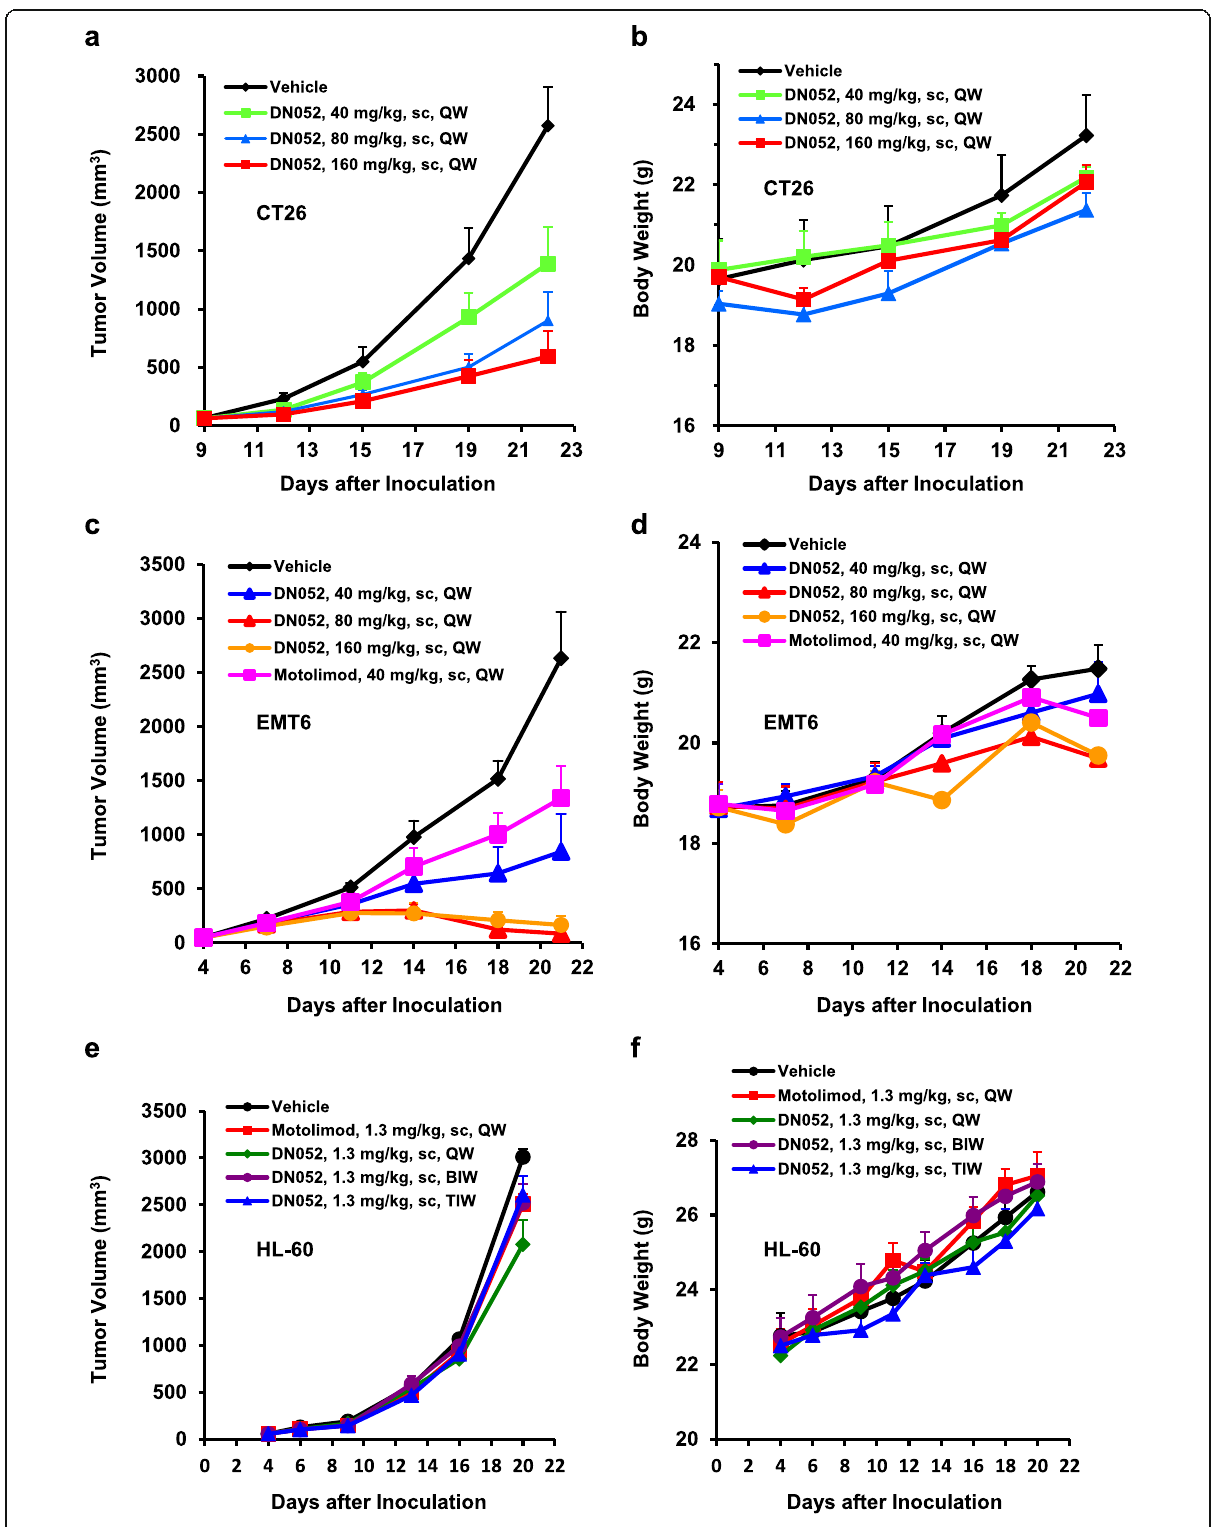
Fig. 3 DN052 was more efficacious than motolimod and well-tolerated as a single agent in various mouse tumor models. DN052 treatment resulted in significant tumor growth inhibition in CT26 colon cancer ( a , b ), EMT6 breast cancer ( c , d ) and HL-60 AML ( e , f ) models. DN052 more strongly suppressed tumor growth than motolimod under the same